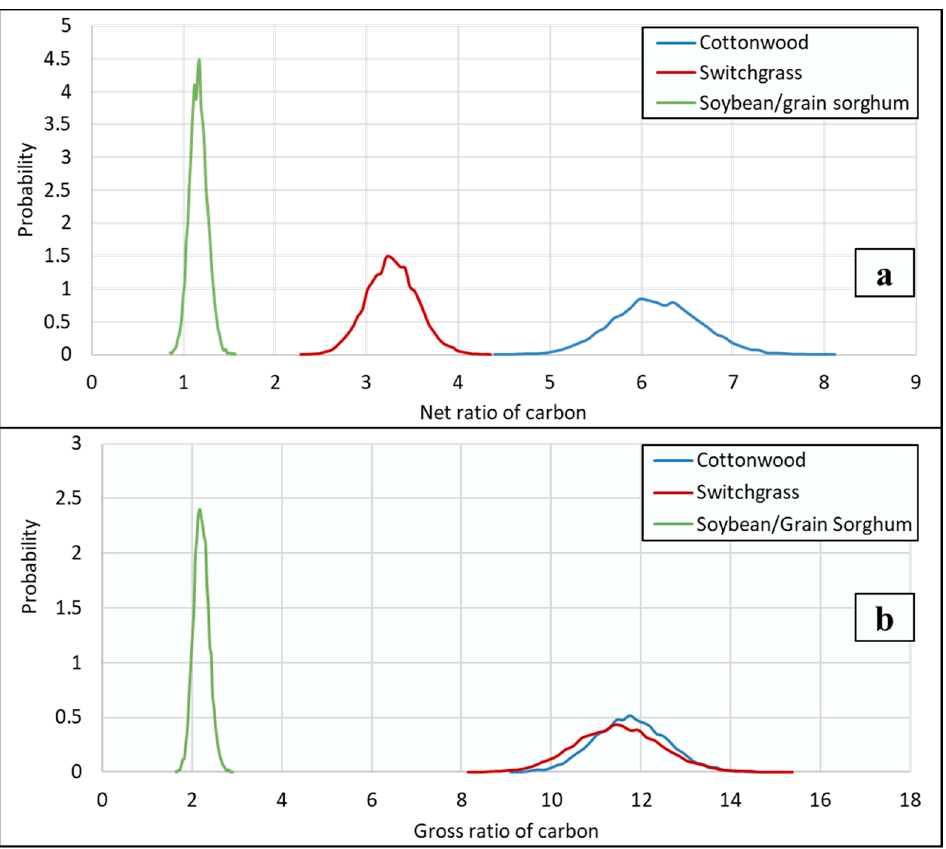
Figure 4. Sensitivity analysis of ( a ) net and ( b ) gross ratio of carbon sequestration to emission.